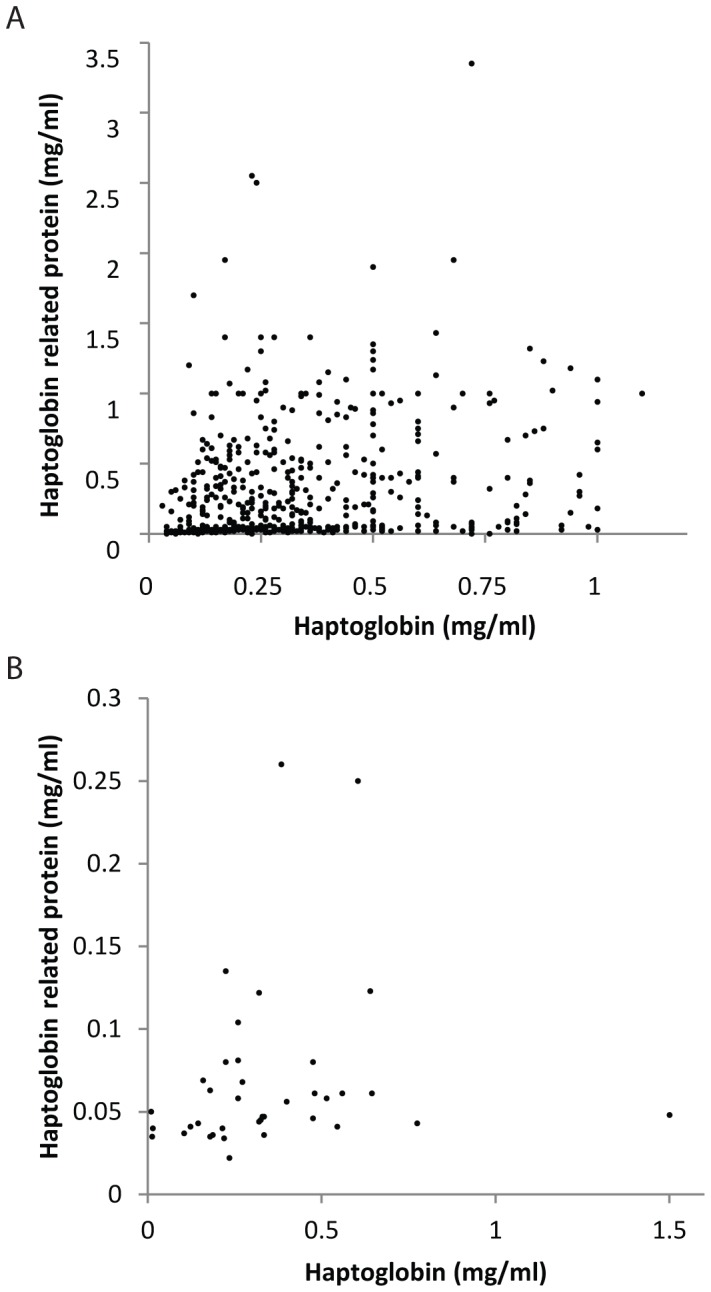
Haptoglobin related protein levels are correlated with haptoglobin levels in A) Gabonese and B) Caucasian children.Scatterplot of raw Hpr values (mg/ml) plotted against raw Hp values (mg/ml). Associations were assessed by Spearmans rho. Hpr was positively correlated with Hp in A) Gabonese children (rs = 0.29, P<0.001), and B) Caucasian children (rs = 0.51, P<0.001).